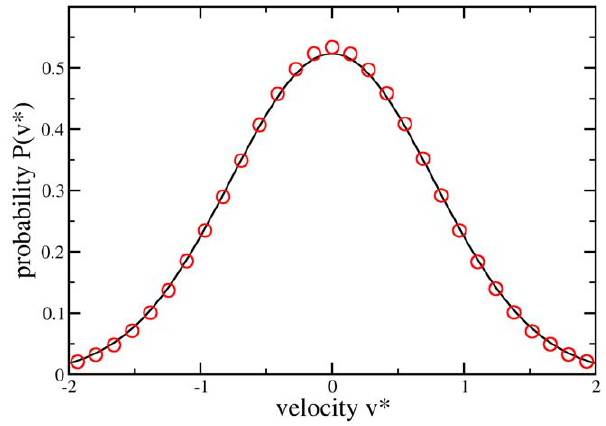
Figure 3. Profile of the kinetic temperature (cid:1) TT kin ~ v m v 2 w = 3 k B along the simulation box x -axis. The dotted line at (cid:1) TT (cid:1) shows the estimate for the MD particles from Eq. (13); full symbols are simulation averages over bin widths of 2 s .